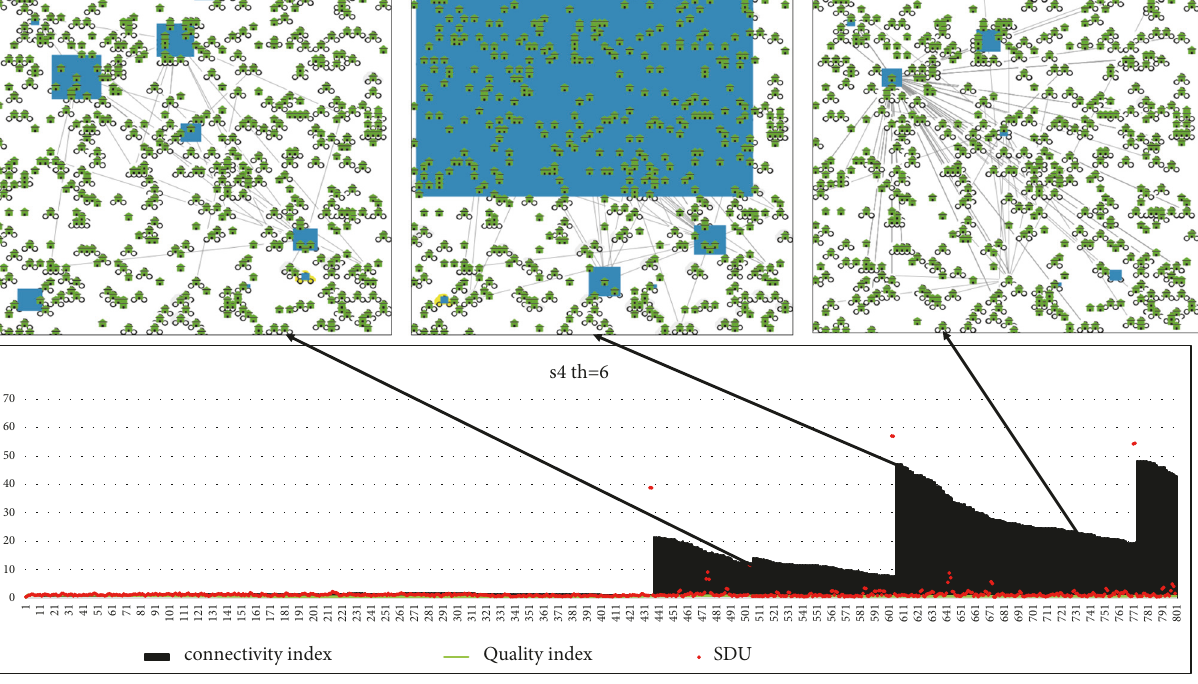
Figure 10: Phase shift analysis example, for 𝑡ℎ 𝑠𝑡𝑟𝑜𝑛𝑔−𝑡𝑖𝑒 = 6 , resources = 15. Each graph above shows a time-series plot of 800 hours. Quality index is shown using green line. The SDU is shown using red points, and quality index is shown through bars fillings in black. The column one (left) shows the simulation view and the column two (right) shows the graph at that time. The top row shows many resources (blue boxes) been utilized by users and its corresponding position in the graph. The size of the box corresponds to the number of users. The middle row shows that all of a sudden the resources are reduced, which turns out to be a tipping point. The things get smoother after second tipping point (the bottom row). Interactions between users are also evident in all three simulation